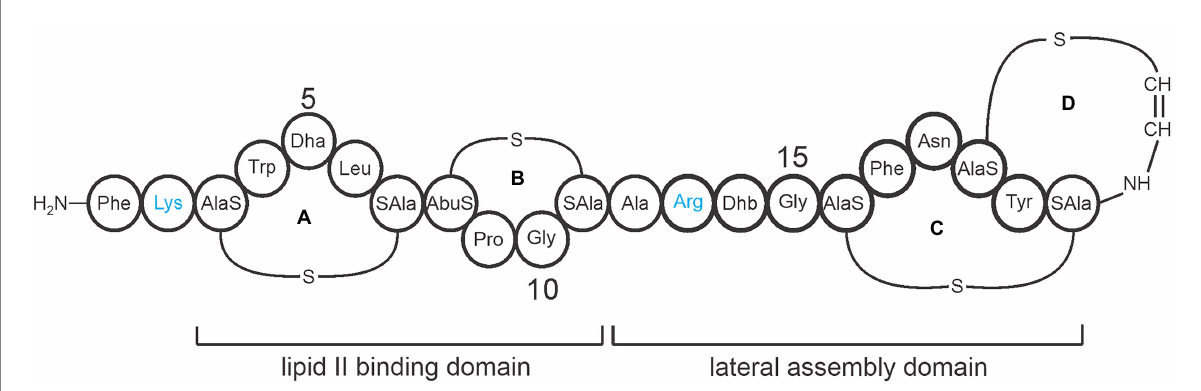
FIGURE 1 Representative covalent structure of Mu1140. The four lanthionine rings are labeled A, B, C, and D. The lipid II binding domain consists of rings A and B, while the lateral assembly domain consists of the hinge region (residues 12 to 15) and rings C and D. Protease-susceptible residues Lys and Arg are shown in blue and represent the sites for the alanine substitutions in the Mu1140 analogs. The amino acid abbreviations Dha is dehydroalanine and Dhb is dehydrobutyrine. The labels AlaS and SAla signifying the residues involved in the lanthionine ring formation, AlaS (Dha), AbuS (aminobutyric acid), and SAla